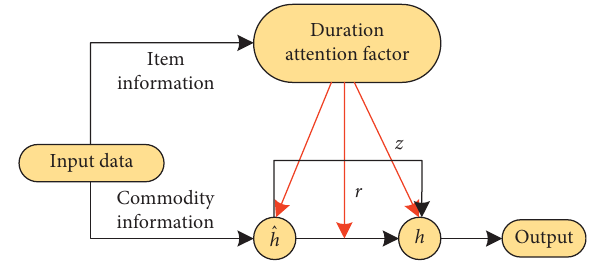
Figure 2: Network structure.